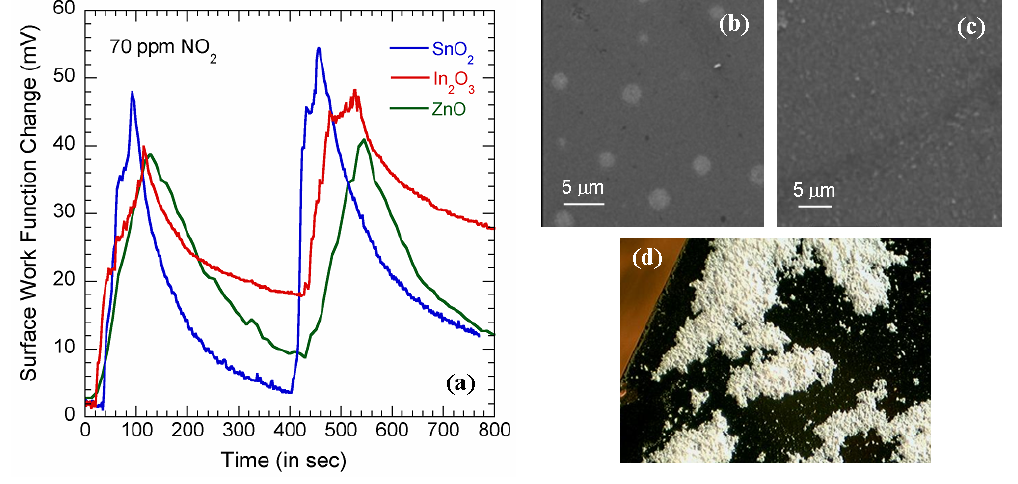
Figure 3. (a) SWF changes of In The gas was switched on and off for 2 cycles. (b) and (c) are the scanning electron micrographs of In clusters of ZnO nanowires spread over silicon substrate.